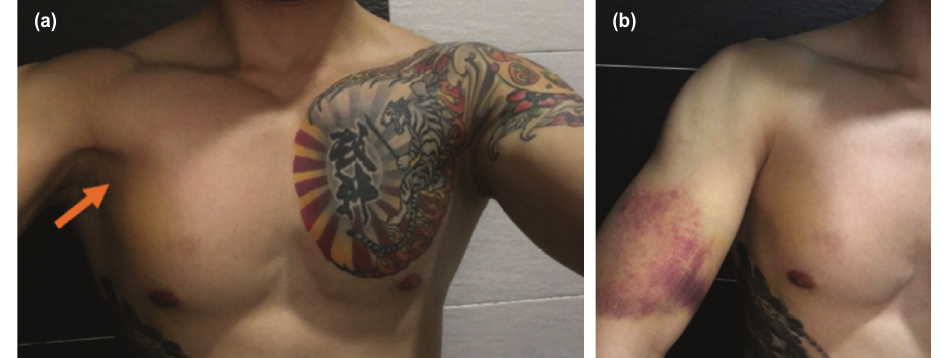
(a) The image of patient was taken 3 days after the PMT ruptured. Arrow showed a step over anterior axillary fold as compared Fig. 1: to the left side. There was bruising and medialisation of PM muscle belly over right lower chest region. Also noted a “dropped nipple sign” as described by Funk. (b) There was large ecchymosis over right anterior arm. Most indicative of insertion tear of PMT.